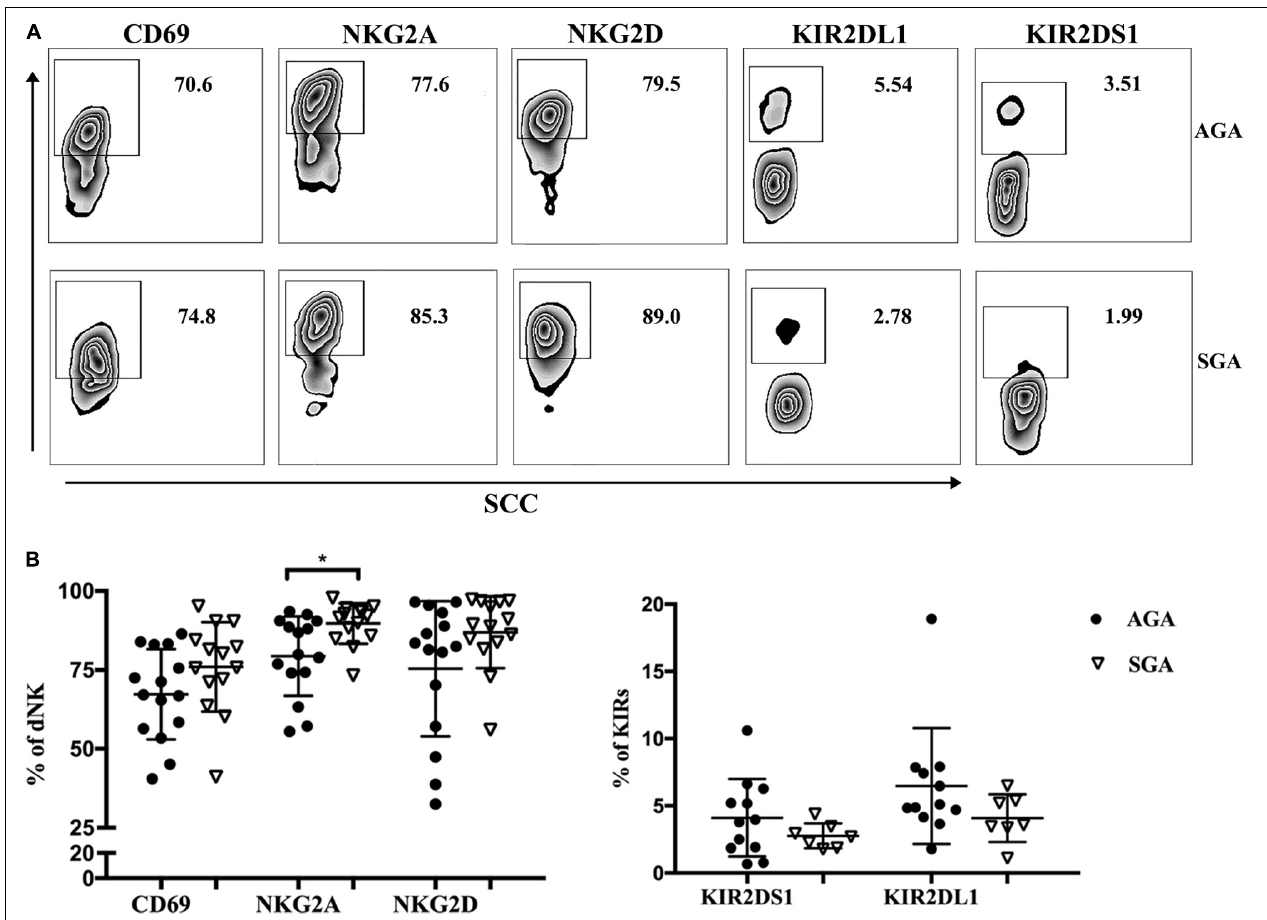
FIGURE 2 | The receptors expressed on dNK cells in SGA. (A) Representative flow cytometry analysis of the expression of CD69, NKG2A, NKG2D, KIR2DS1, and KIR2DL1 on gated CD3 - CD56 + dNK cells in SGA (the lower row) and AGA (the upper row). (B) The frequency of CD69, NKG2A, NKG2D, KIR2DS1, and KIR2DL1 on dNK cells in SGA ( n = 7–14) and AGA ( n = 12–15). * p <